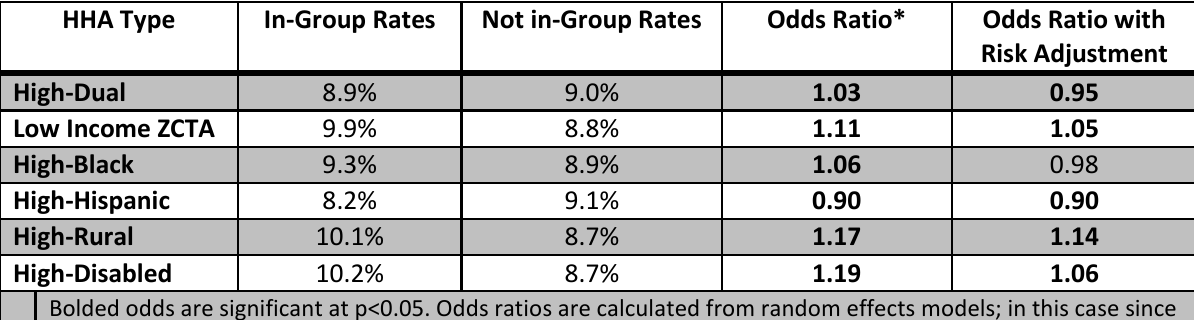
Table 13.8: HHAs Serving a High Proportion of Socially At-Risk Beneficiaries, ED Use FYs